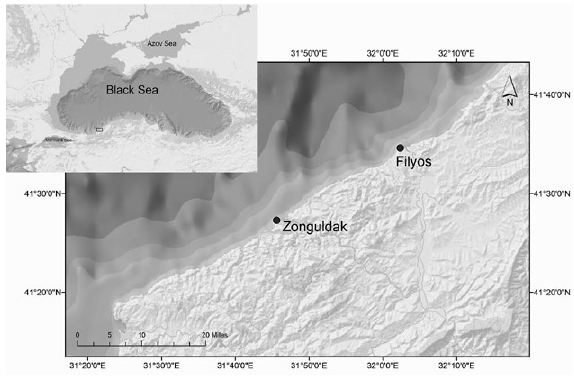
Fig. 1. – Map of the study area with two points chosen for the land- based observations in the Zonguldak administrative